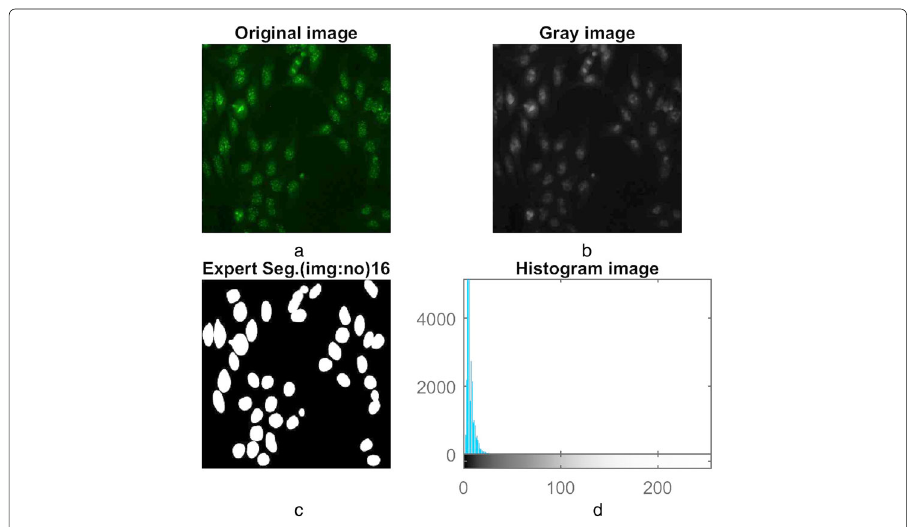
Fig. 5 a Original image. b Its gray level. c Expert segmentation. d Image